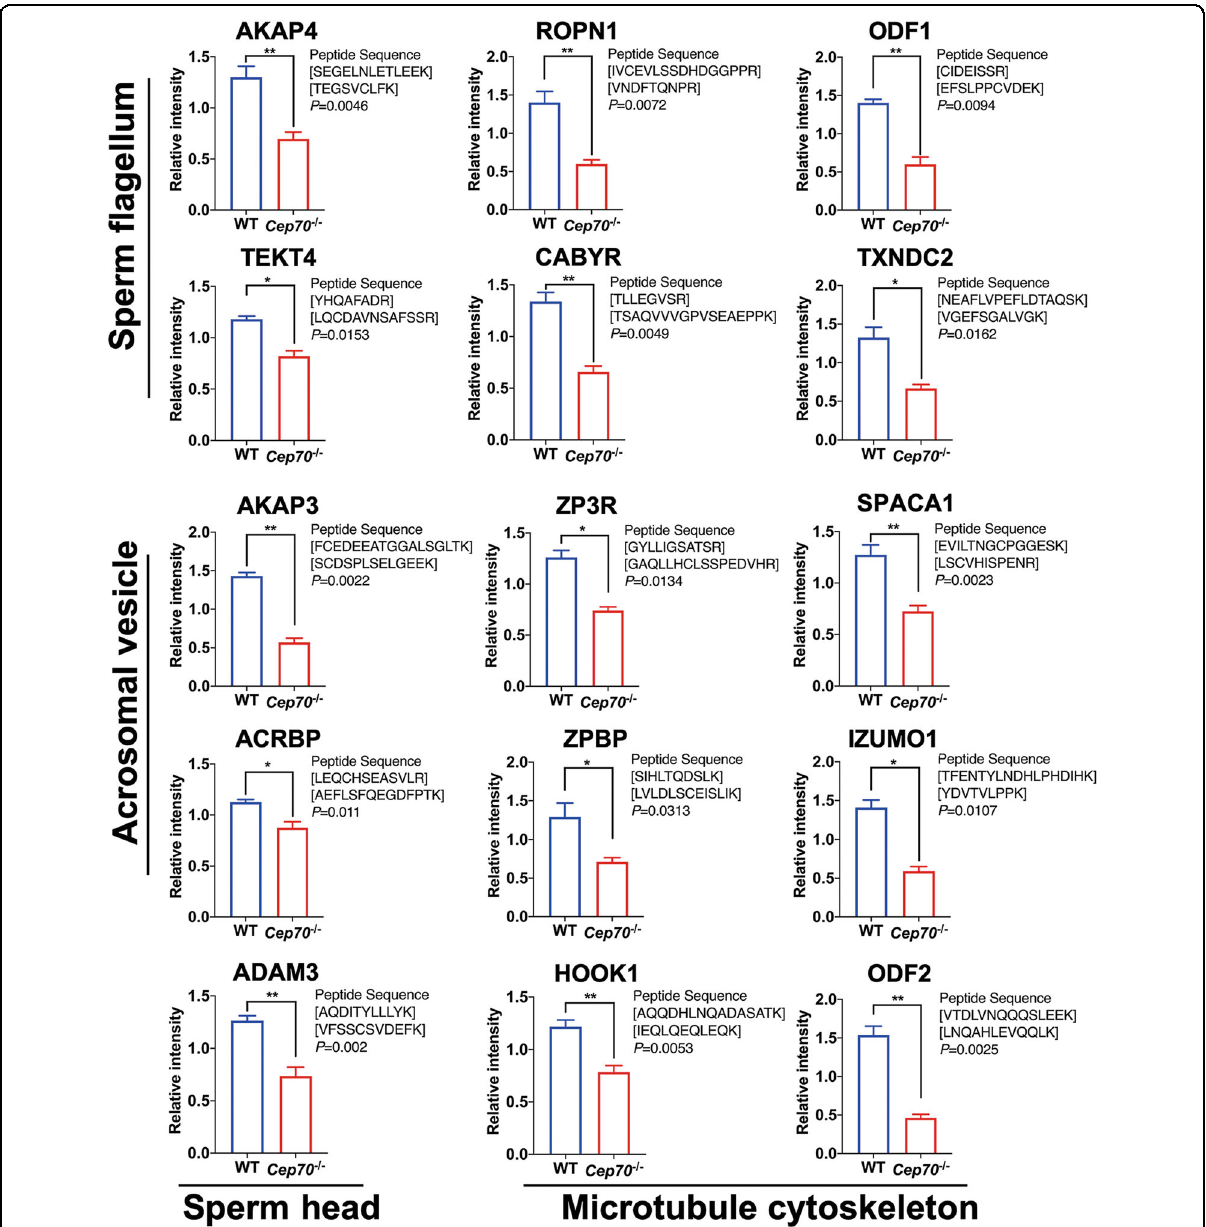
Fig. 7 Fifteen proteins were validated in WT and Cep70 − / − male mice testes by PRM. Fifteen downregulated proteins associated with sperm fl agella, sperm head, acrosomal vesicle, and microtubule cytoskeleton, including AKAP4, ROPN1, ODF1, TEKT4, CABYR, TXNDC2, AKAP3, ZP3R, SPACA1, ACRBP, ZBPB, IZUMO1, ADAM3, HOOK1, and ODF2 showed signi fi cant differences in Cep70 − / − male mice testes compared with WT testes ( n = 3). Data are presented as the mean ± SD. p < 0.05 (*), 0.01 (**), or 0.001